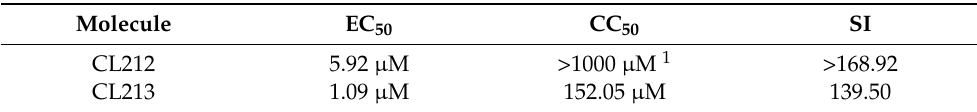
Table 1. EC 50 and CC 50 values of CL212 and CL213 against CVA9 on A549 cells. The selectivity index was calculated by CC 50 /EC 50 .